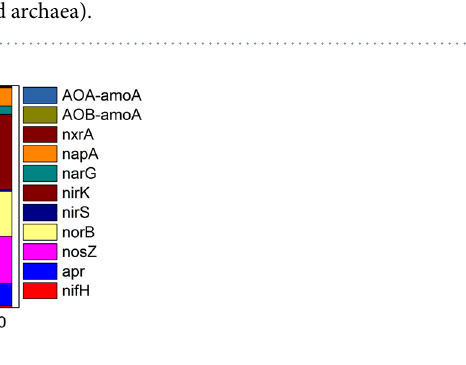
Figure 4. The relative richness of nitrogen functional genes during artificial vegetation restoration. (The relative richness was defined as the percentage of absolute abundance of a nitrogen functional gene divided by the absolute abundance of all nitrogen functional